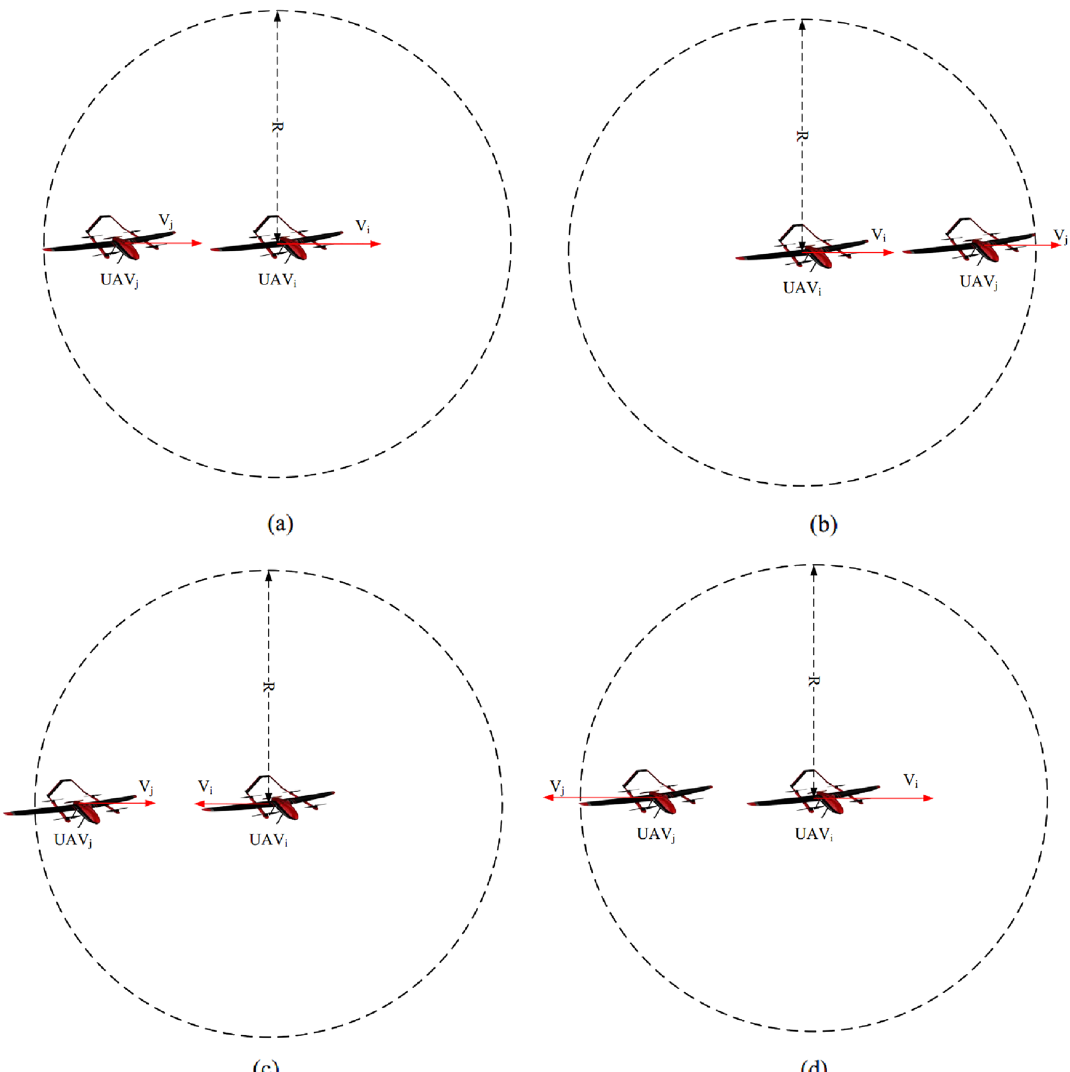
Figure 3. Various modes of UAV i and UAV j